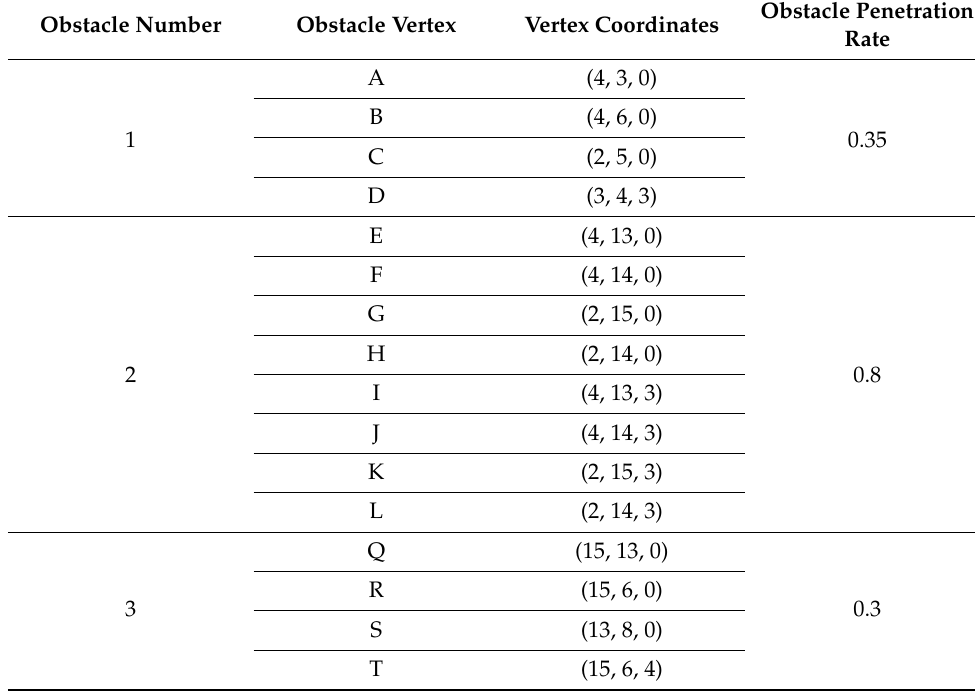
Figure 9. Elevation of candidate points.